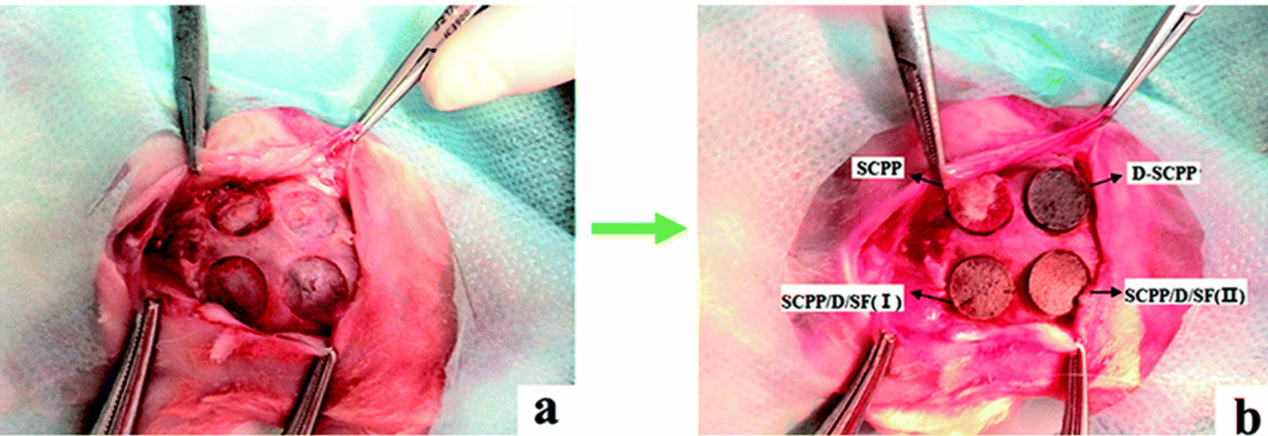
Figure 4. Photographs of animal modeling in vivo. Defects on the cranial bone ( a , b ) materials implanted. Courtesy of: Wang X, Gu Z, Jiang B, Li L, Yu X. Surface modification of strontium-doped porous bioactive ceramic scaffolds via poly(DOPA) coating and immobilizing silk fibroin for excellent angiogenic and osteogenic properties. Biomater Sci. April 2016;4(4):678–88. doi: 10.1039/c5bm00482a. Epub 12 February 2016. PMID: